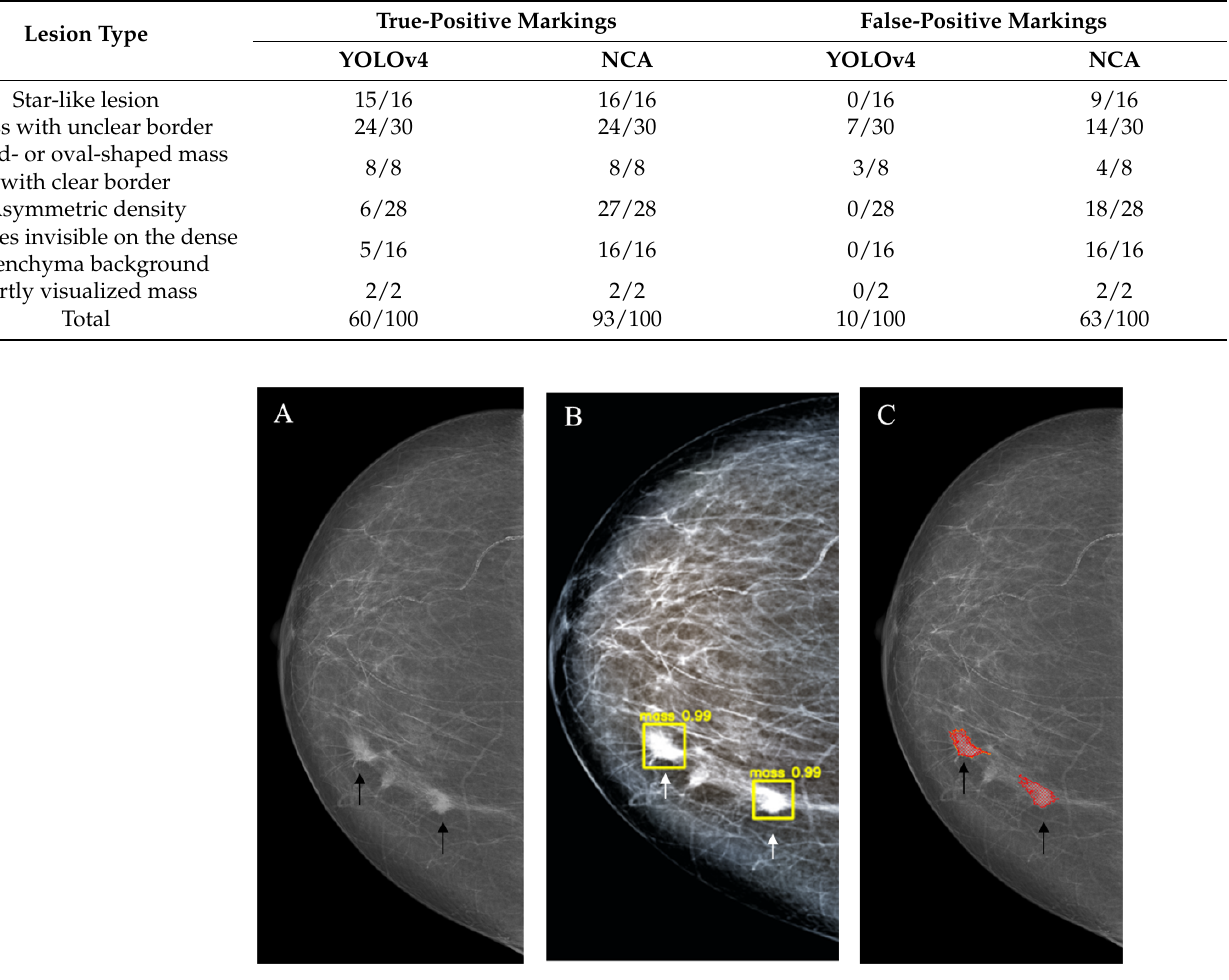
Figure 5. Mass with unclear border (arrows). ( A ): Source image; ( B ): YOLOv4 outcome; ( C ): NCA outcome. lesion (arrow).